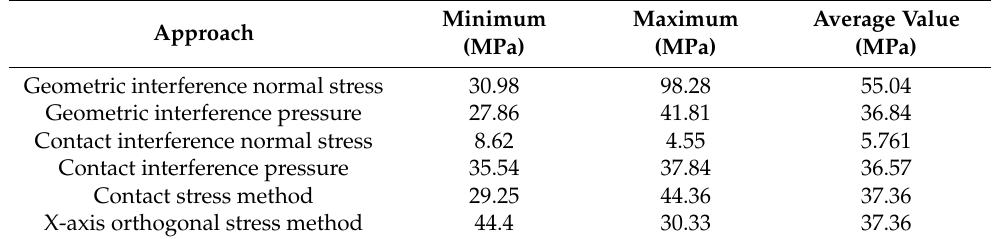
Table 9. Statistics of simulation results.